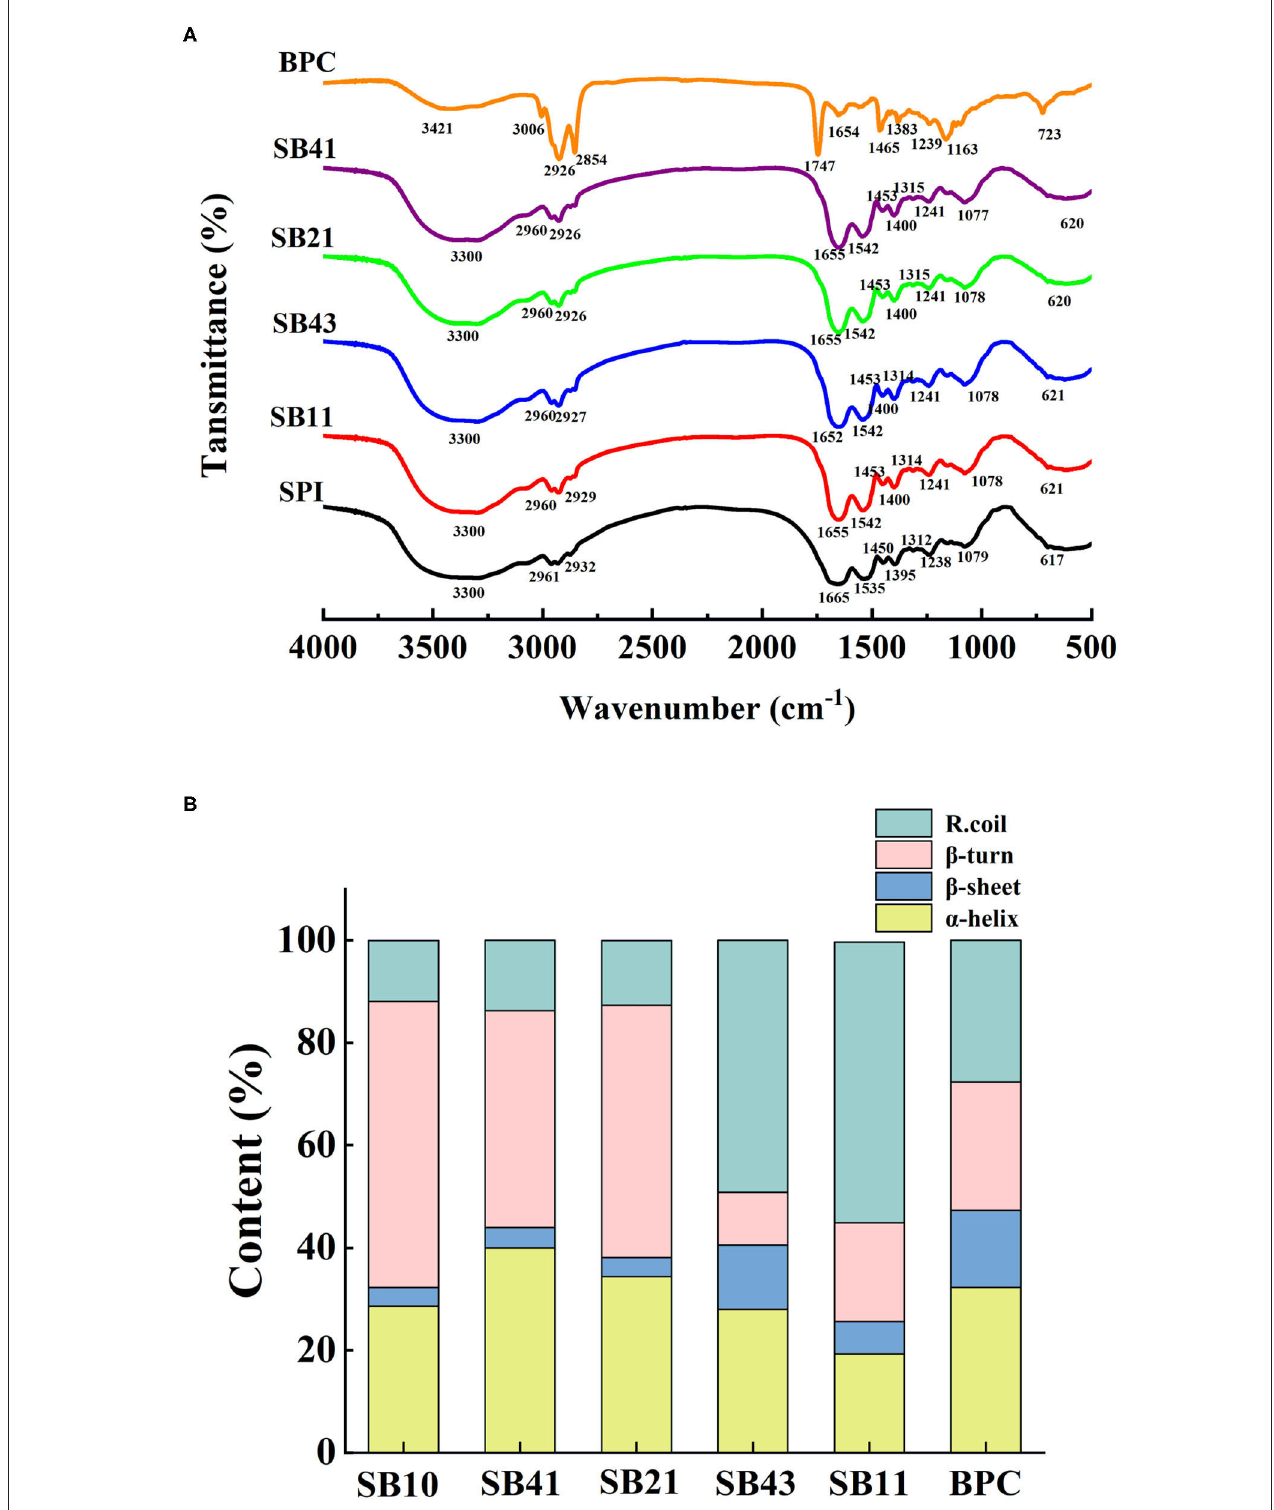
FIGURE 2 | FTIR spectra (A) , secondary structure (B) of SPI, BPC, and different SPI/BPC ratios (4:1, 2:1, 4:3, 1:1).